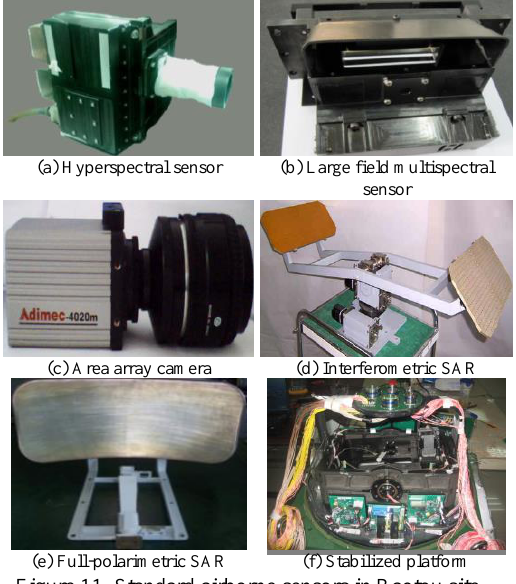
(f) Stabilized platform Figure 11. Standard airborne sensors in Baotou